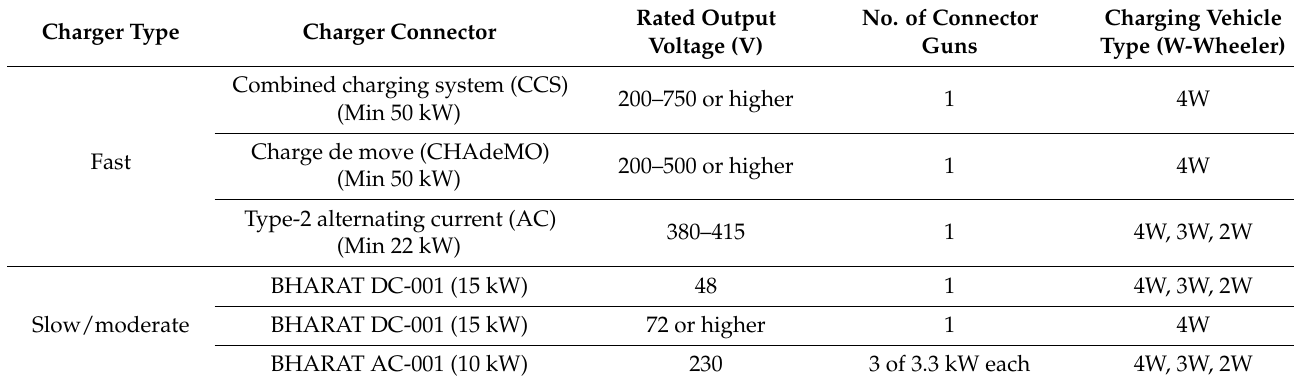
Table 2. EV charger specifications [11,21,24].